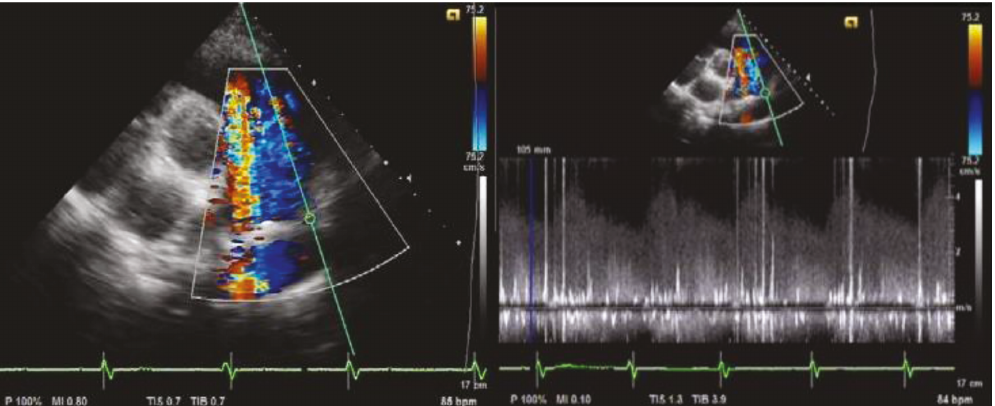
Figure 1: In the short axis view at the level of the aortic valve, there is a retrograde mosaic jet entering the distal pulmonary artery from the posterolateral direction, indicative of patent ductus arteriosus, with the following measurements: PSAX 9 mm, 10 mm (with color); suprasternal 8.1mm, 1 mm (with color). Continuous fl ow across the defect is demonstrated on spectral Doppler. Computed Qp :Qs is 1.18.